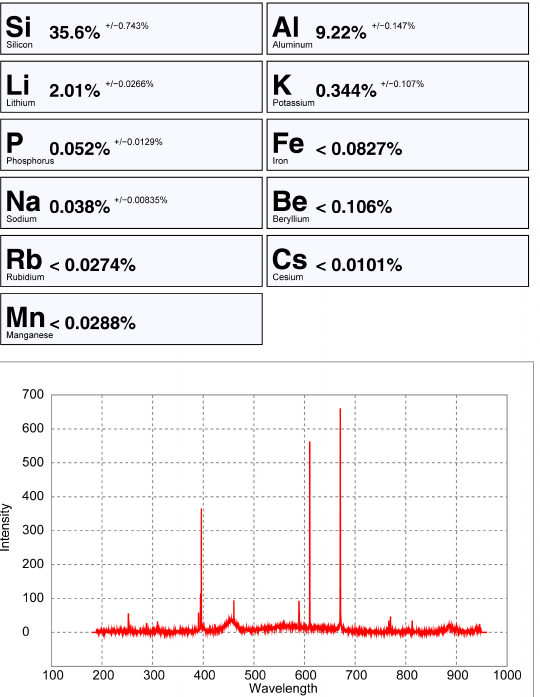
Figure 20. pLIBS analysis of the spodumene sample 32-C1 with the Spd_Barroso calibration.